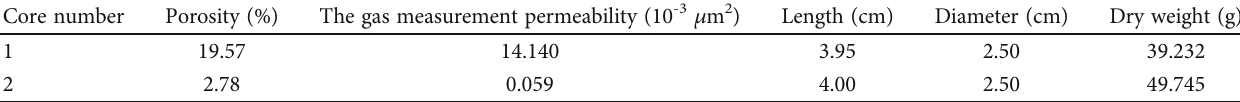
Table 1: The physical parameters of